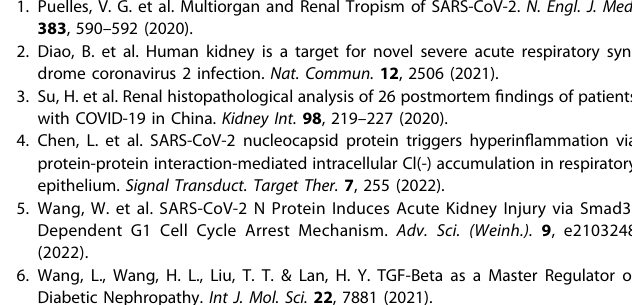
Fig. 1 SARS-CoV-2 N Protein induces AKI under diabetic conditions via the Smad3-Ripk3/MLKL necroptosis pathway. a Ultrasound- microbubble-mediated kidney-speci fi cally overexpressing SARS-CoV-2 N protein can induce severe tubular necrosis (*) in db/db mice, particularly in those with older age db/db mice (HE-staining, scale bar = 50 μ m). b Semi-quantitative analysis of tubular necrosis in db/m and db/db mice with or without overexpressing SARS-CoV-2 N protein at the age of 8, 16 and 32 weeks. c , d Serum levels of creatinine and BUN in db/m and db/db mice with or without overexpressing SARS-CoV-2 N protein at the age of 8, 16, 32 weeks. e Quantitative analysis of renal Kim1 protein expression in db/m and db/db mice with or without overexpressing SARS-CoV-2 N protein at the age of 8, 16, 32 weeks. f , g Quantitative real-time PCR for Kim1 mRNA and SARS-CoV-2 N mRNA expression in db/m and db/db mice with or without overexpressing SARS-CoV-2 N protein at the age of 8, 16, 32 weeks. h Quantitative real-time PCR for Ripk3 and MLKL mRNA expression in 16-week-old db/m and db/db mice with or without overexpressing SARS-CoV-2 N protein. i Western blot analysis of Flag-NP, p-Smad3, Ripk3, p-MLKL and MLKL expression in the kidneys of 16-week-old db/m and db/db mice with or without overexpressing SARS-CoV-2 N protein. j Co-localization between SARS-CoV-2 N protein (green) and p-Smad3 (red) in the AKI kidney (scale bar = 50 μ m, and scale bar = 25 μ m in ampli fi ed images). k Co-localization between p-MLKL (green) and p-Smad3 (red) in the AKI kidney (scale bar = 50 μ m). l Interaction between Flag-SARS-CoV-2 N protein and Smad3 in HK-2 cells by Co-IP. m Western blot analysis shows that overexpression of SARS-CoV-2 N protein induces and promotes Smad3 phosphorylation and nuclear translocation in HK-2 cells under high AGE conditions (50 μ g/ml for 30 mins). n , o ChIP assay for detecting the binding of Smad3 to Ripk3 and MLKL promoter region in response to AGE (50 μ g/ml). p Quantitative real-time PCR for Ripk3 and MLKL mRNA expression in HK-2 cells. q Western blot analysis of Ripk3, p-MLKL and MLKL protein expression in HK-2 cells with or without SARS-CoV- 2 N protein overexpression and AGE stimulation (50 μ g/ml for 6 h). r Treatment with SIS3 (10 μ M) blocks SARS-CoV-2 N protein-induced activation of Smad3 (p-Smad3) and Ripk3/MLKL signaling in HK-2 cells under high AGE stimulation (50 μ g/ml) conditions. s Renal pathological changes at the age of 16-week-old Smad3 KO-db/m, Smad3 WT-db/m, Smad3 KO-db/db, and Smad3WT-db/db mice with overexpression of SARS-CoV-2 N protein (HE-staining, scale bar = 50 μ m). t , u Semi-quantitative analysis of tubular necrosis (*) and serum creatinine in Smad3 KO/WT-db/m or Smad3 KO/WT-db/db mice with SARS-CoV-2 N protein overexpression. v Western blot analysis of p-Smad3, Ripk3, p-MLKL and MLKL expression in Smad3 KO/WT-db/m or Smad3 KO/WT-db/db mice with overexpressing SARS-CoV-2 N protein. w Therapeutic effect of SIS3 (10 mg/kg, daily) on SARS-CoV-2 N-induced renal pathology in db/m and db/db mice (HE-staining, * tubular necrosis, scale bar = 50 μ m). x , y Therapeutic effect of SIS3 on SARS-CoV-2 N-induced tubular necrosis and serum creatinine in db/m and db/db. z Western blot analysis shows the inhibitory effect of SIS3 on SARS-CoV-2 N protein-induced p-Smad3, p-MLKL, and expression of Ripk3 and MLKL in the kidney of db/m and db/db mice. The data represents as the mean ± SEM for at least 3 independent experiments in vitro or for groups of 6 mice in vivo. G Glomerulus, S3KO Smad3 knockout mice, S3WT Smad3 wild-type mice, 8w 8 weeks, 16w 16 weeks, 32w 32 weeks; *, necrotic tubules. * P < 0.05, ** P < 0.01, *** P < 0.001 vs. VC group; # P < 0.05, ## P < 0.01, ### P < 0.001 as indicated; † P < 0.05, †† P < 0.01, ††† P < 0.001 vs. AGE + VC, S3WT + NP, or NP + DMSO